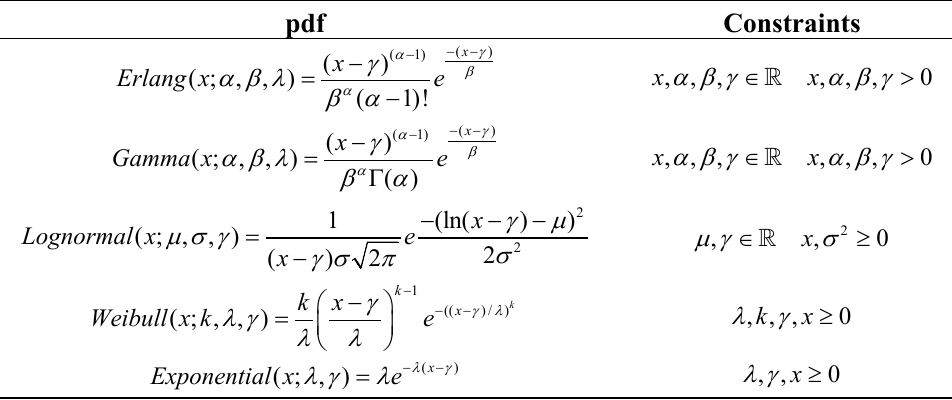
Table 3. Mathematical forms of the parametrical pdfs used in our characterization. All of them are considered three- parametrical, being γ the offset , i.e. , the lower bound for the